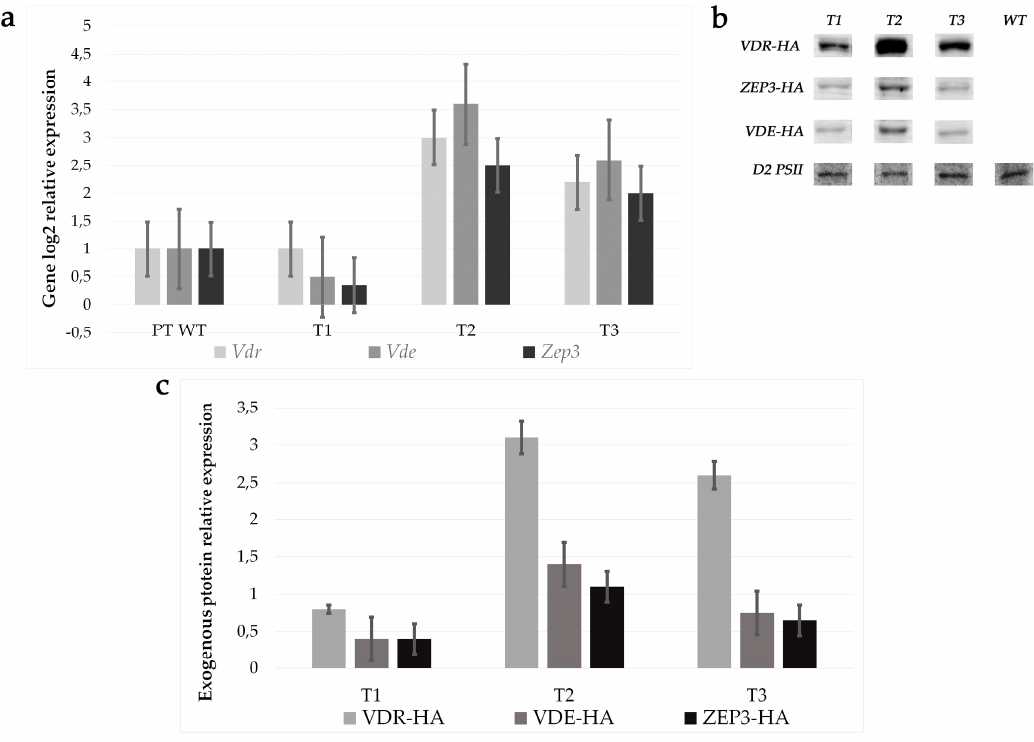
Figure 4. Transcripts and HA tagged proteins relative expression in P. tricornutum wild type and OE strains T1, T2 and T3. ( a ), Relative gene expression (endogenous and exogenous) as assessed by qPCR. ( b ), Western blot analysis performed on PT WT, T1, T2 and T3 in order to detect exogenous HA tagged proteins and control protein D2 of PSII. ( c ), relative exogenous protein expression.